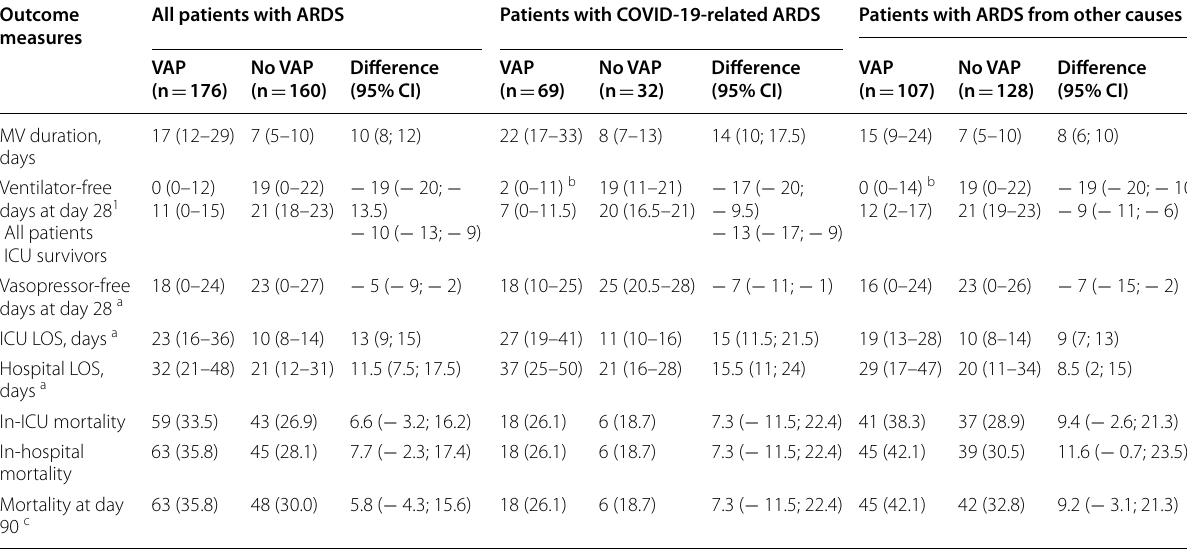
Data are expressed as number (%) or median (interquartile range), with median difference for continuous variable and absolute risk difference for ICU and in-hospital mortality rates ARDS acute respiratory distress syndrome, VAP ventilator-associated pneumonia, CI confidence interval, COVID-19 coronavirus disease 2019, MV mechanical ventilation, ICU intensive care unit, LOS length of stay a P < 0.001 for the comparison between COVID-19 and non-COVID-19 patients and/or according to whether patients developed VAP within the first 28 days or not b Median difference (95% CI), 2 ( 8; 6) days − c Nine patients were lost to follow-up at day 90 (5 patients with VAP and 4 patients without